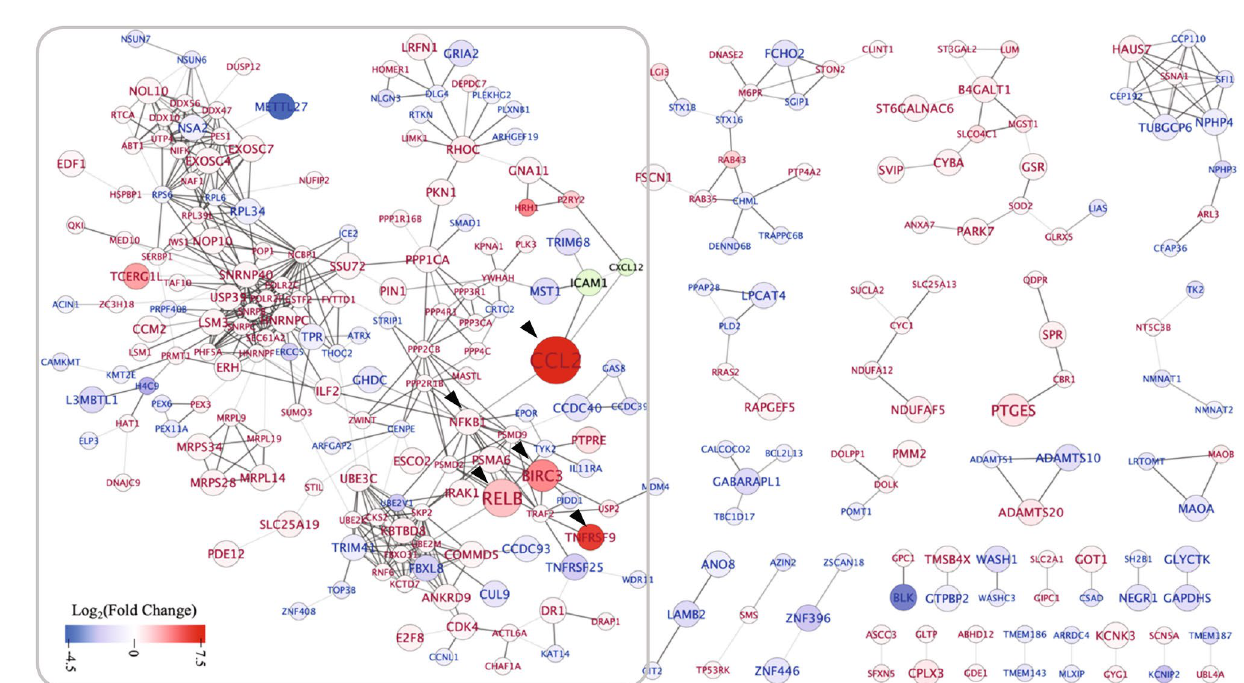
Figure 5. Diagram depicts the protein–protein interaction (PPI) network of the unique DEGs in the 2BmCherry transcriptome. The circles represent the protein nodes, the bigger size indicates the higher magnitude of statistical significance. The colors indicate the magnitude of changes, the log 2 (fold changes); red color indicates the upregulation, blue color indicates the downregulation, and green color indicates the undetermined fold change. The significant nodes are indicated by arrowheads. The light-to-dark grey colors of the connected lines indicate the increment of confidence of interaction (combined score 0.700–0.999). The nodes in the box show the biggest